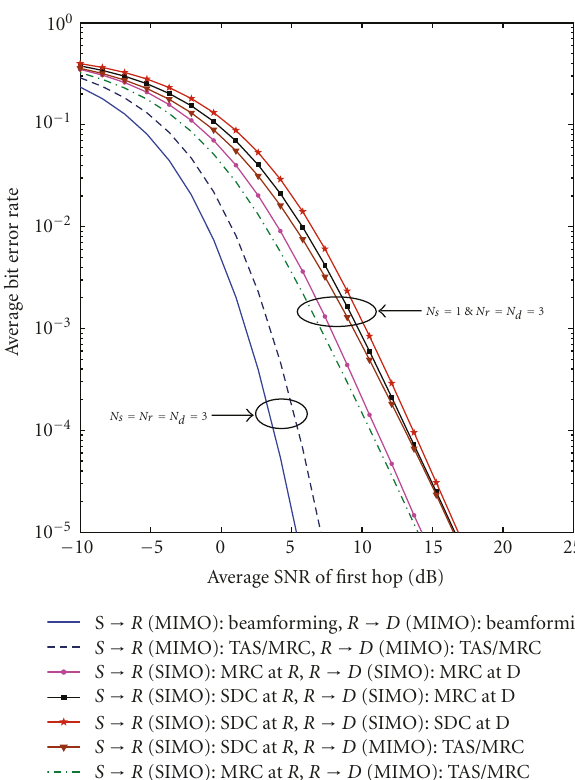
= γ , ρ = 0, θ d = π/ 4, 1 2